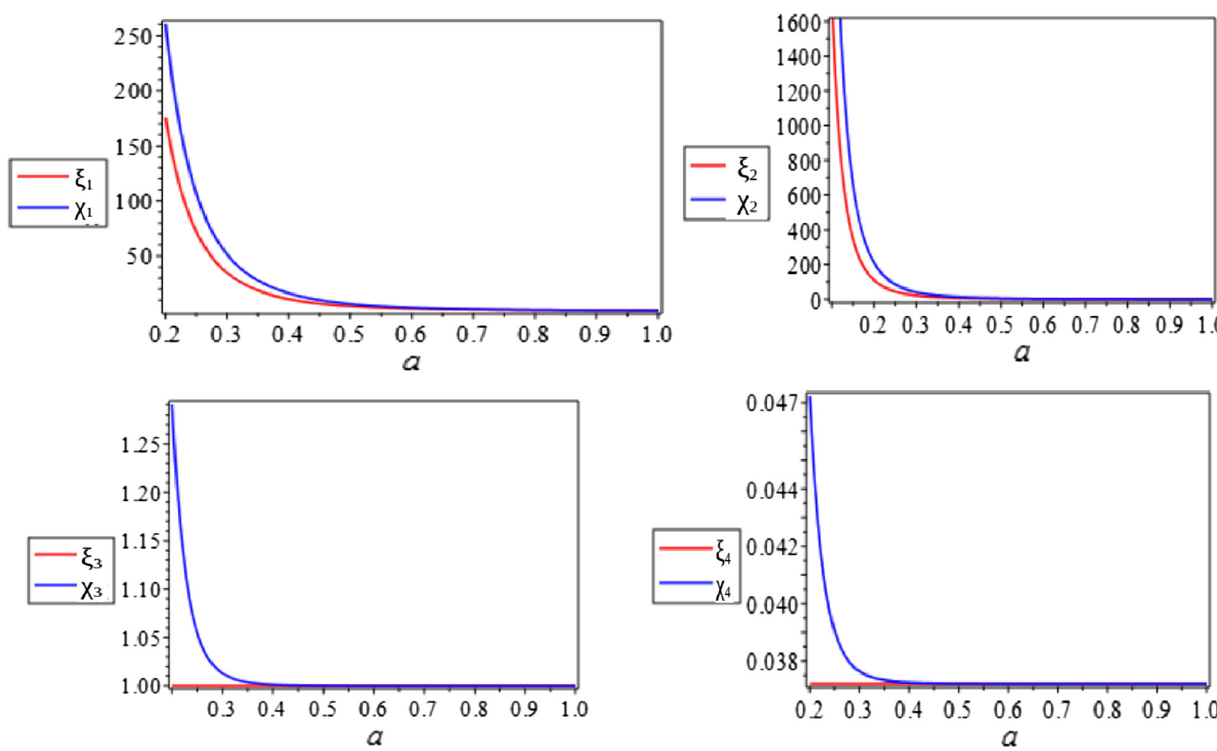
Fig. 2 For the plots: in the upper-left panel, ξ 1 associated with χ 1 versus a , in the upper-right panel, ξ 2 , χ 2 versus a , in the lower-left panel, ξ 3 , χ 3 versus a and in the lower-right panel, ξ 4 , χ 4 versus a for radiation- torsion system in OCG. We use c = 0 . 9 and A = 0 . 7 for the numerical